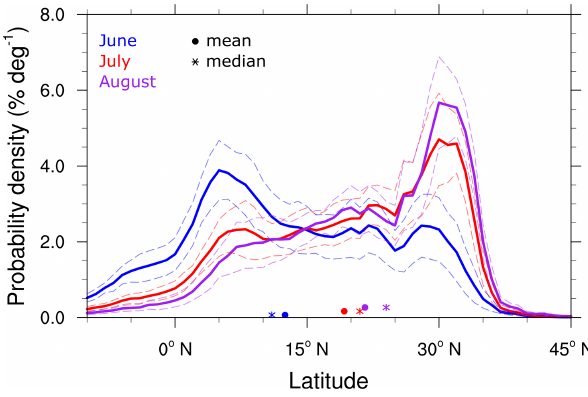
Figure 11. Probability density (%deg − 1 ) with respect to latitude of trajectory intersections with the PBL split according to June (blue), July (red) and August (purple). Mean (dots) and median (crosses) are given as well. Dashed lines mark the interannual standard devi-